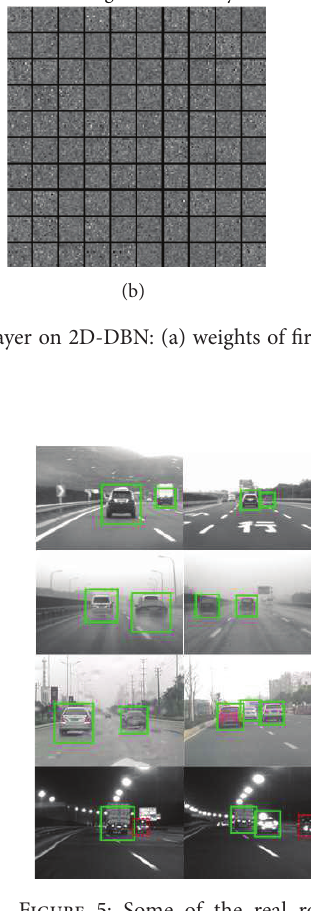
Figure 5: Some of the real road vehicle sensing results. First row: daylight highway situation; second row: raining day highway situation; third row: daylight urban situation; forth row: night highway with road